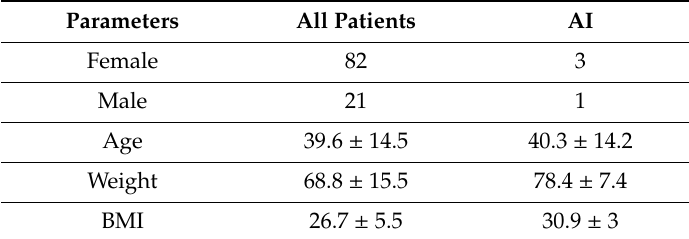
Table 1. Demographic characteristics of the cohort of patients included in the study and in those with